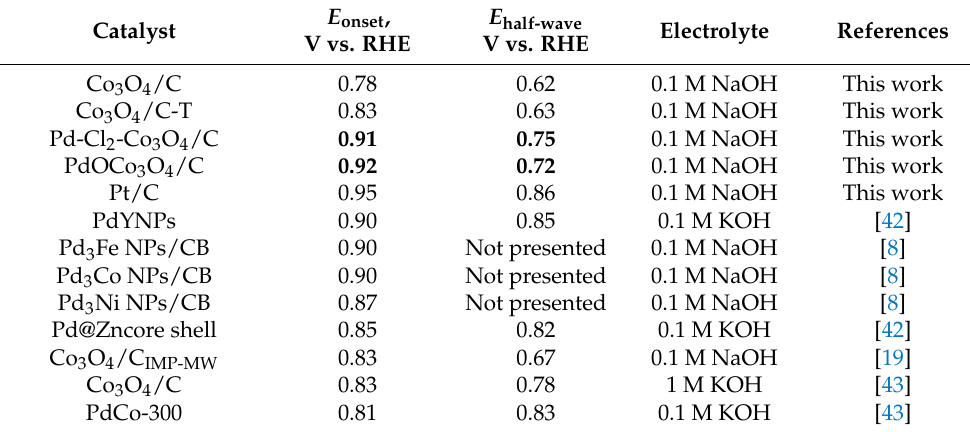
Figure 9. Koutecky–Levich plots of the investigated catalysts at different potentials in an O 2 -saturated 0.1 M NaOH solution. Table 4. The comparison of potentials of various